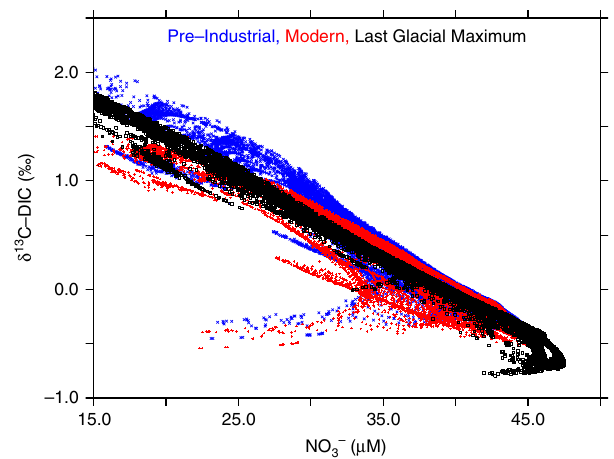
Fig. 3 Model simulations of [NO 3 − ]- δ 13 C DIC coupling in the intermediate Paci fi c for different time intervals. Correlation between [NO 3 − ] and δ 13 C DIC in intermediate water depths (700 – 2000m) of the Paci fi c for the for the modern (red crosses; 1990 – 2010 average after accounting for decreased atmospheric δ 13 C CO2 ), pre-industrial (blue x ’ s) and LGM (black squares) from the 3D ocean biogeochemical isotope